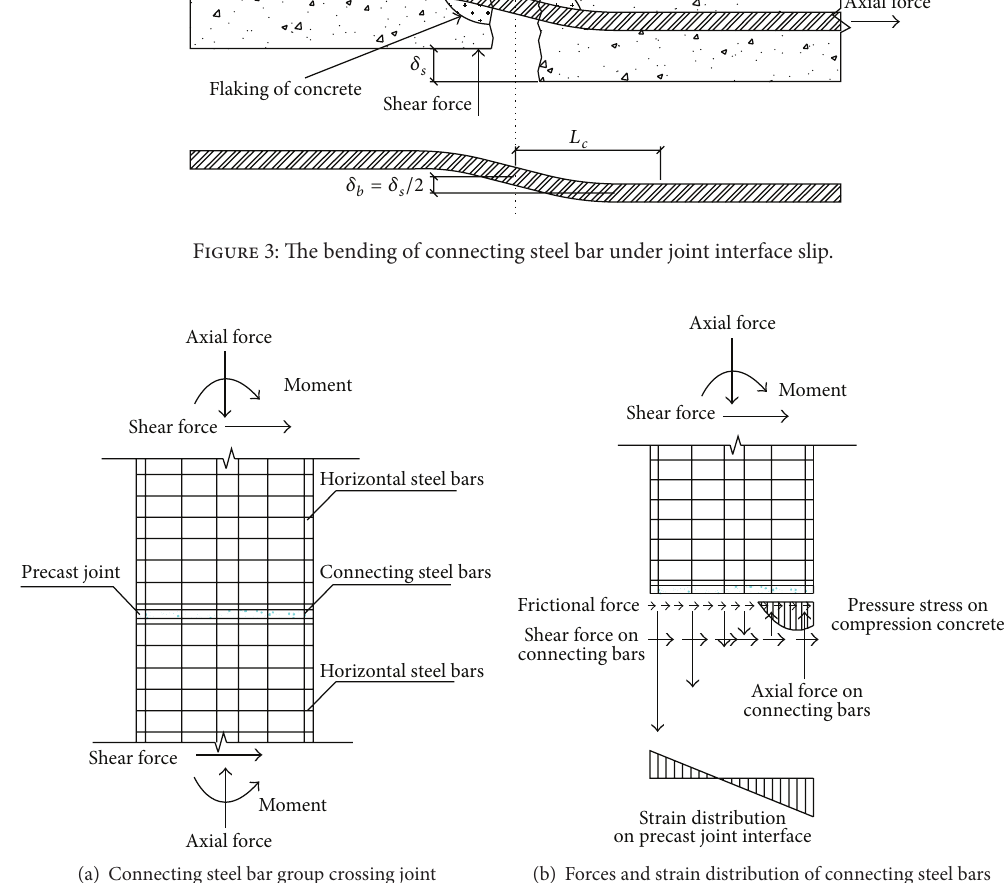
Figure 4: Connecting steel bar group crossing precast shear wall joint and forces and strain